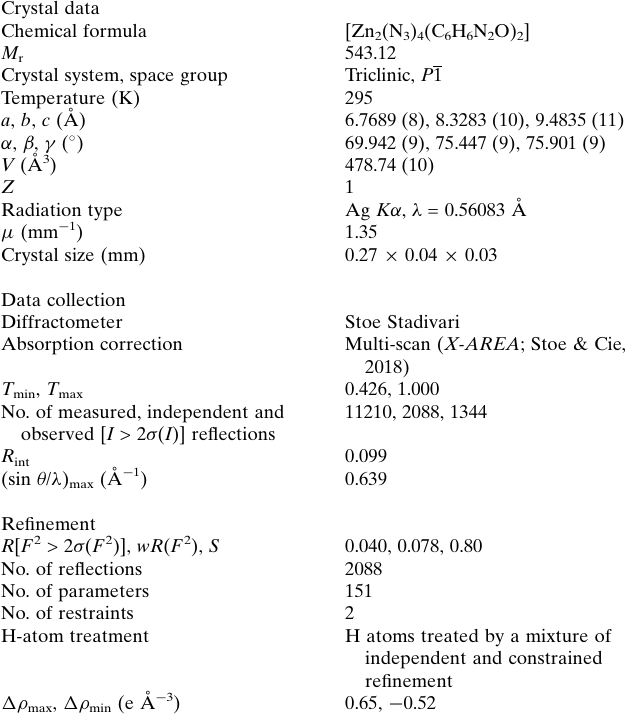
Table 4 Experimental details. Crystal data Chemical